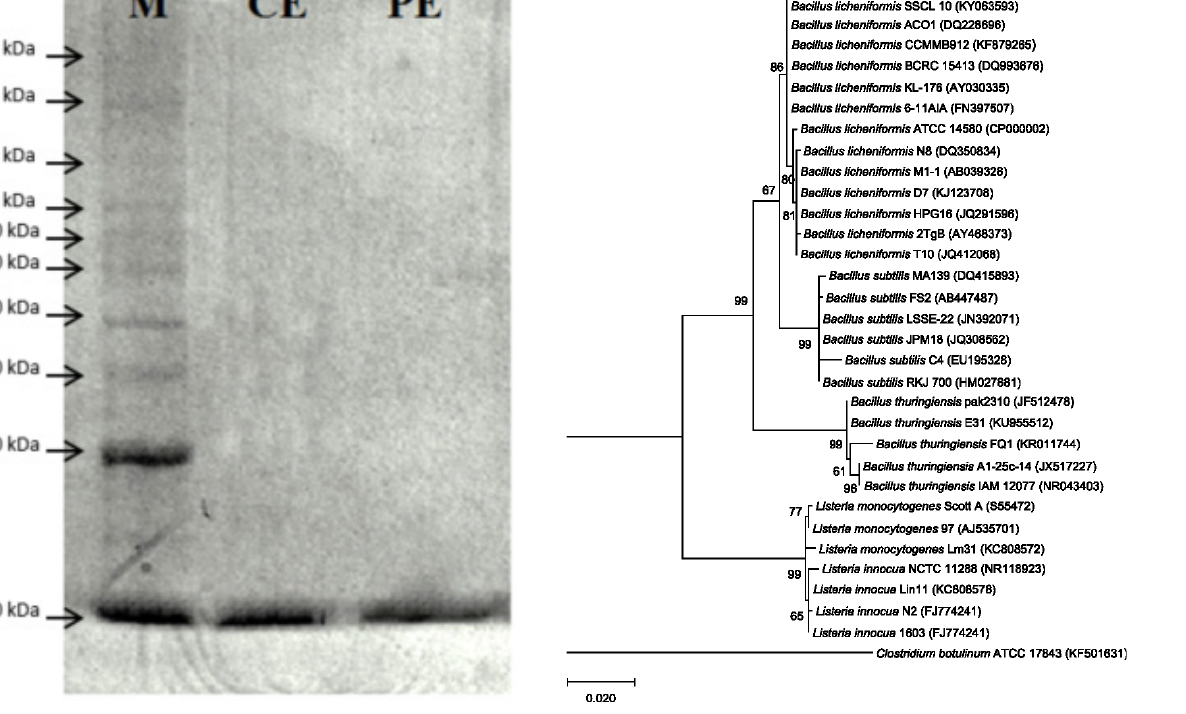
Figure 4 - Maximum likelihood phylogenetic tree based on 16S rRNA gene sequences. The studied isolate is shown in bold. Bootstrap with 1000 resamplings was performed and values greater than 50% shown in